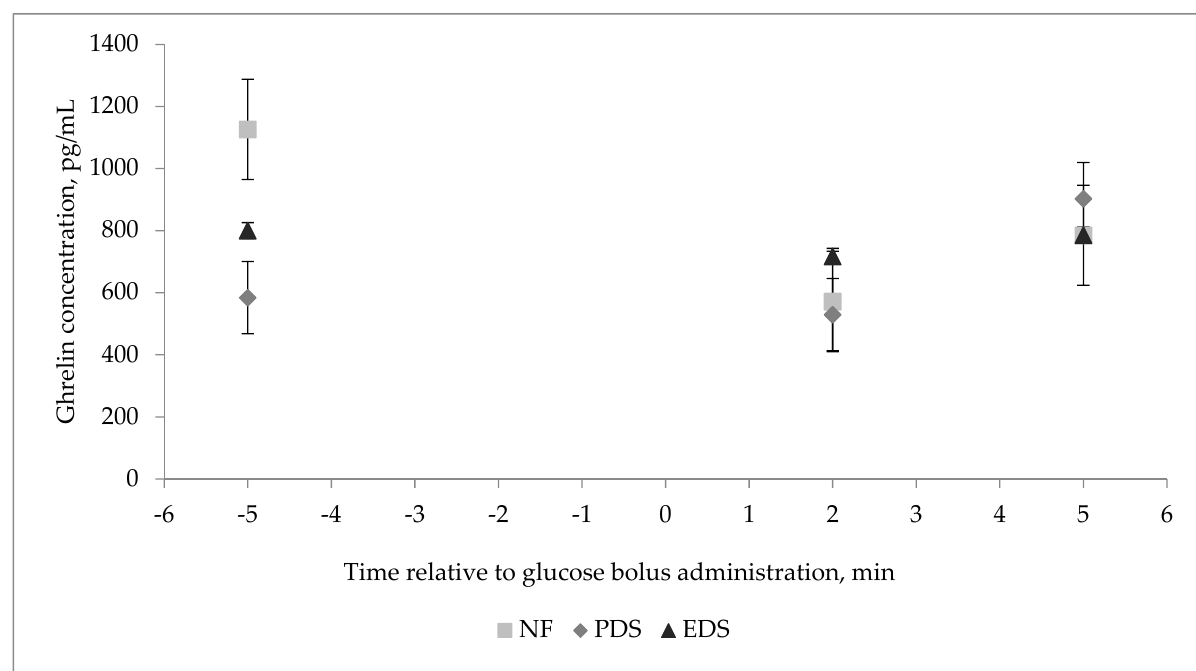
Figure 3. Effect of a fatty acid enriched diet during the last 50 days of gestation and offspring’s sex on glucose concentration during the glucose tolerance test on offspring during the finishing period (18 lambs; 2 sex and 3 dam treatments). Data are presented as the LSmean of FA × Time ( p = 0.34; standard error of the mean (SEM) = 13.64); time ( p ≤ 0.01; SEM = 8.16). No difference ( p ≥ 0.14) for FA, sex, and FA × Sex. Treatments of ewes supplemented with Ca salts of MUFA (PDS; EnerGII, Virtus Nutrition LLC, Corcoran, CA), PUFA (EDS; Strata G113, Virtus Nutrition LLC, Corcoran, CA), or no supplementation (NF) during the last 50 days of